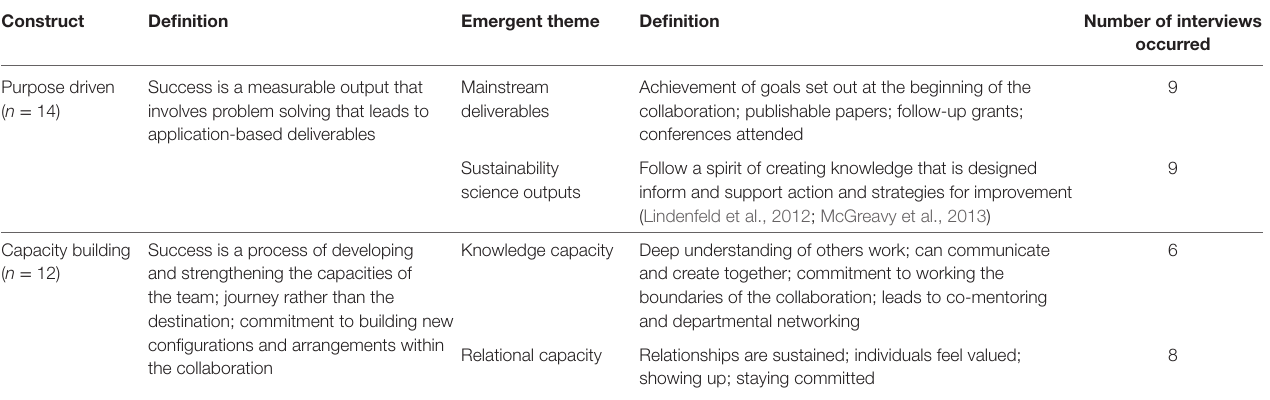
TaBle 1 | Constructs and